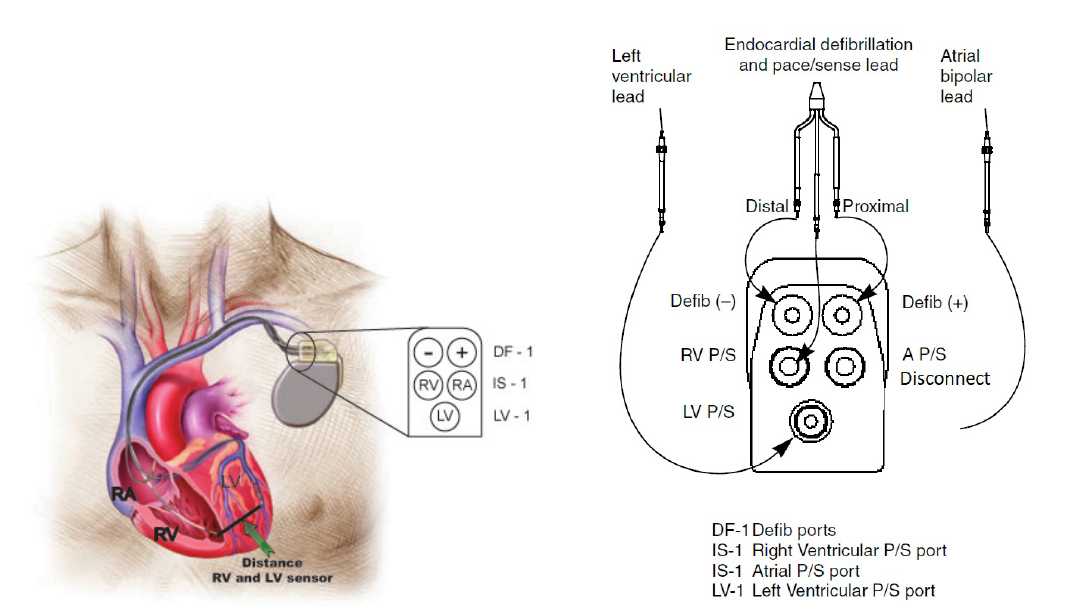
Figure 2. CRT-D device inserted into the ventricles of the heart ( left ) and connections in the device ( right ).